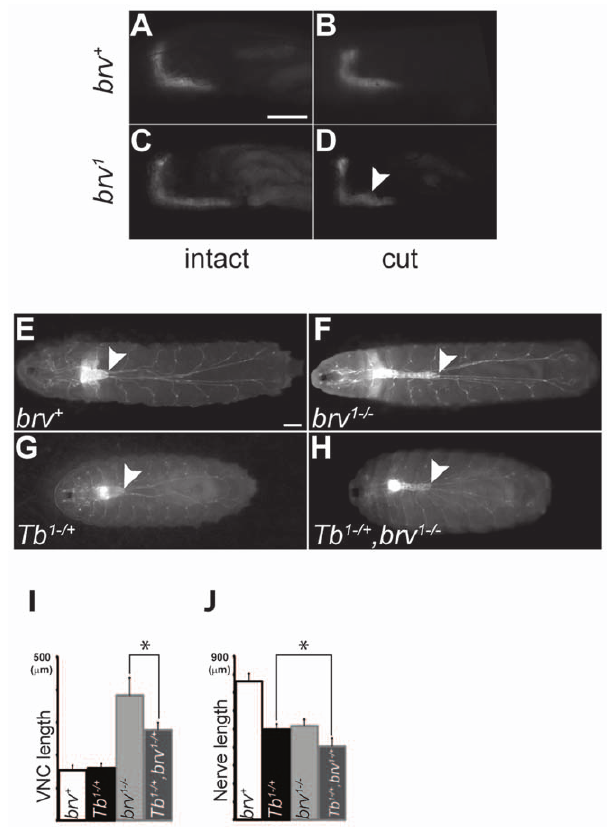
Figure 7. In brv mutant larvae the VNC appears to be under tension of peripheral nerves. Representative pictures of L2 larvae from brv + (A, B) and brv 1 mutants (C, D) expressing Elav-mCD8-GFP before (A, C) and after (B, D) dislodging the connections of the posterior most peripheral nerves. Arrowhead in (D) points towards a kink that appeared during relaxation of the VNC in brv 1 mutants. Representative pictures from brv + (E), brv 1-/- (F), Tb 1-/ + (G) and brv 1-/- , Tb 1-/ + mutant (H) L3 larvae expressing Nrv2-GAL4;UAS-GFP (S65T) . The e\tension of the VNC in brv 1-/- , Tb 1-/ + is reduced as compared to brv 1-/- . Histograms (I, J) quantify the average lengths of VNCs and posterior-most peripheral nerves. brv 1-/- , Tb 1-/ + VNCs are significantly shorter as compared to brv 1-/- mutants (*: p=0.0005). White arrowheads indicate the posterior tip of the VNC. Bars: 100 m m.